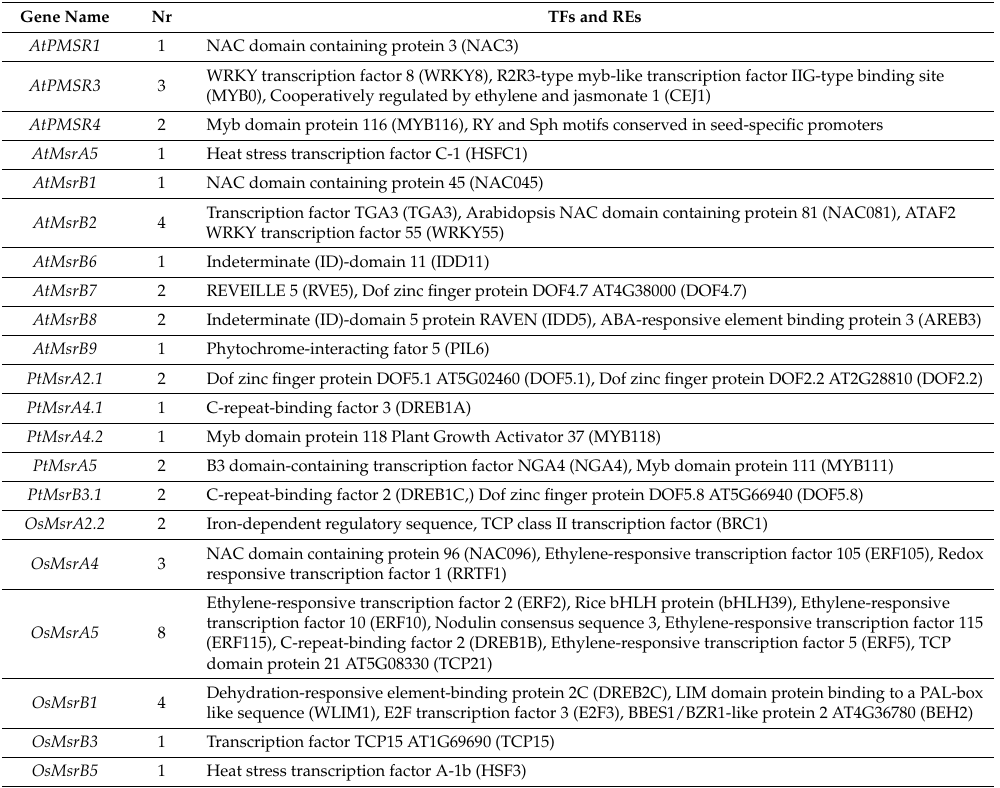
Table 3. List and number (nr) of TFs and REs predicted to interact with the promoter region of one specific MsrA or MsrB gene originating from the Arabidopsis thaliana (At), Populus trichocarpa (Pt), and Oryza sativa (Os) genomes. The predictions were made using MatInspector software, and intersections of the lists of elements were calculated while using the Venn web